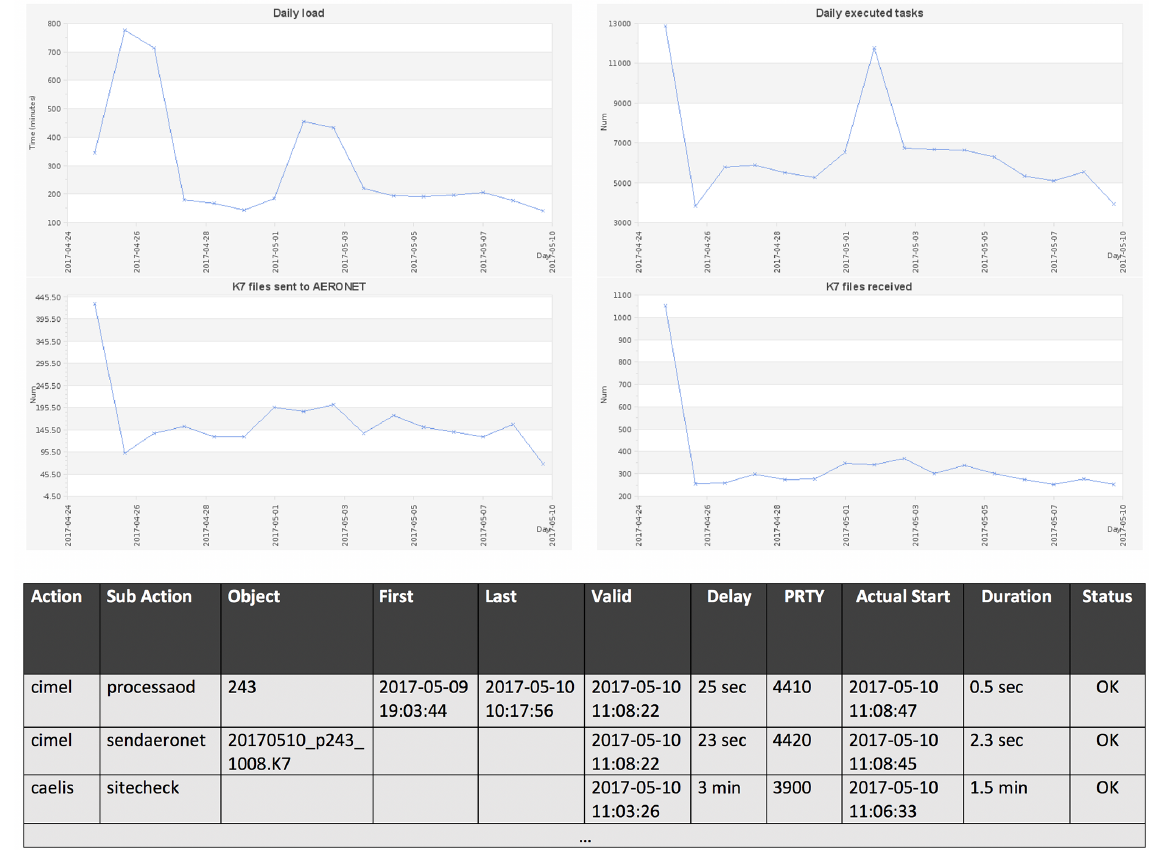
Figure 6. Plots represent CÆLIS load from different measurements: minutes of CPU per day, number of tasks executed per day and number of photometer raw data files sent to AERONET and received from stations. Those plots are constructed based on log information. The table at the bottom shows an example of the log. Delay indicates the difference between actual start and valid time therefore indicating NRT